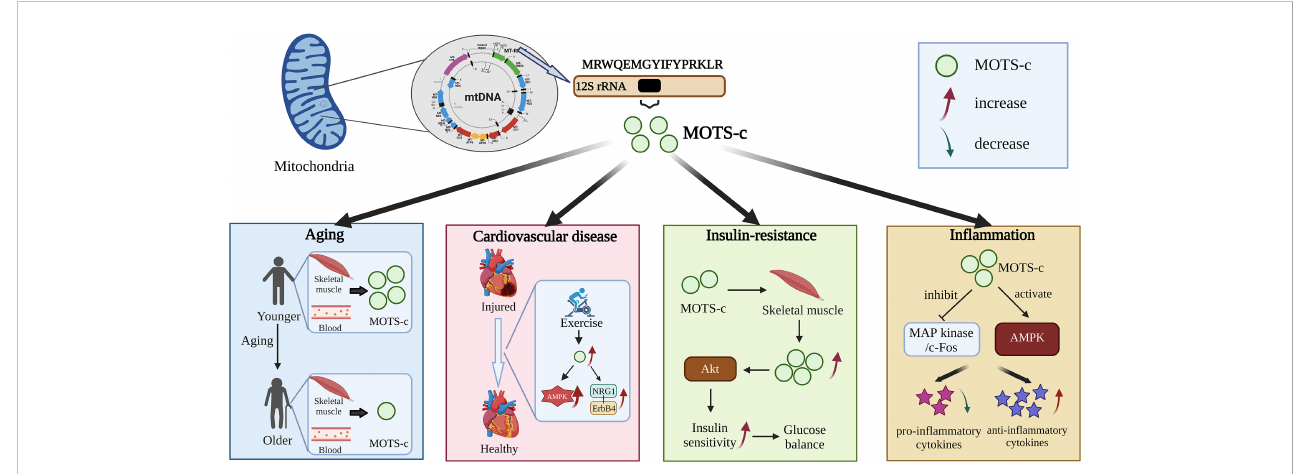
FIGURE 1 Effects of MOTS-c against